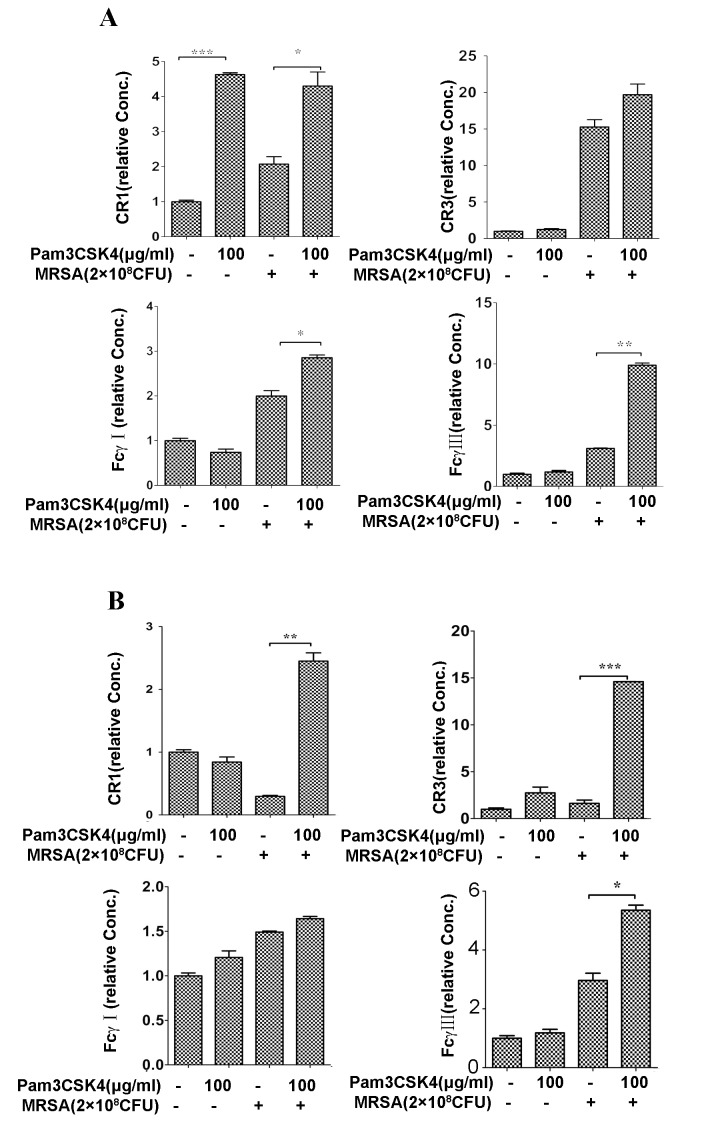
Pam3CSK4 enhances mRNA expression of Fcγ receptor (FcγR) and complement receptor (CR).KM mice were treated with Pam3CSK4 for 24 h prior to MRSA infection. After 6 h (A)and 12 h(B), the mRNA expression of FcγR(Ⅰ,Ⅲ) and CR(1,3) in lungs were performed by quantitative PCR. Data are expressed as the mean ± SEM of 3–5 mice/time from three independent experiments. Note: *P<0.05; **P<0.01 and ***P<0.001 versus normal saline-treated mice.